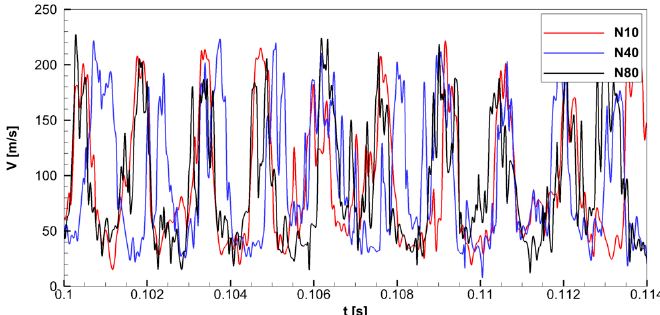
. m = 6.8039 g / s. Fluids 2020 , 5 , x